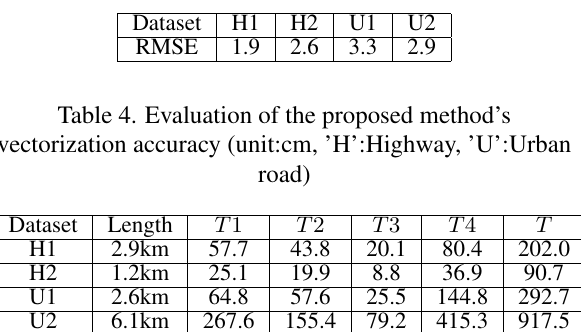
Table 5. Time performance of the proposed method (unit:second, ’H’:Highway, ’U’:Urban